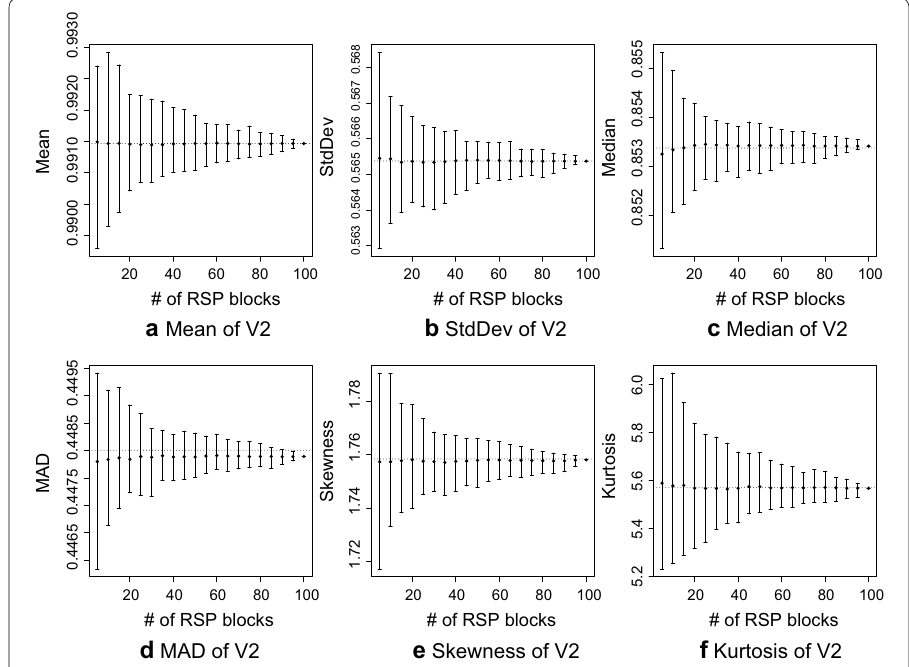
Fig. 5 Summary statistics of V2 in HIGGS. Incremental estimation of summary statistics of V2 using samples of RSP blocks of HIGGS data ( g = 5 ). The dotted line represents the true value of the statistic calculated from the entire HIGGS data